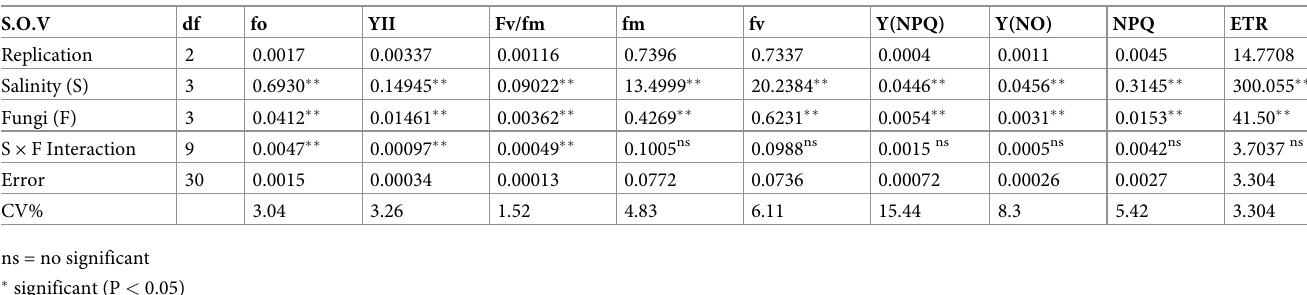
Table 2. Variance analysis of salinity and P . indica and AMF effects on measured chlorophyll fluorescence parameters of peppermint. S.O.V df fo